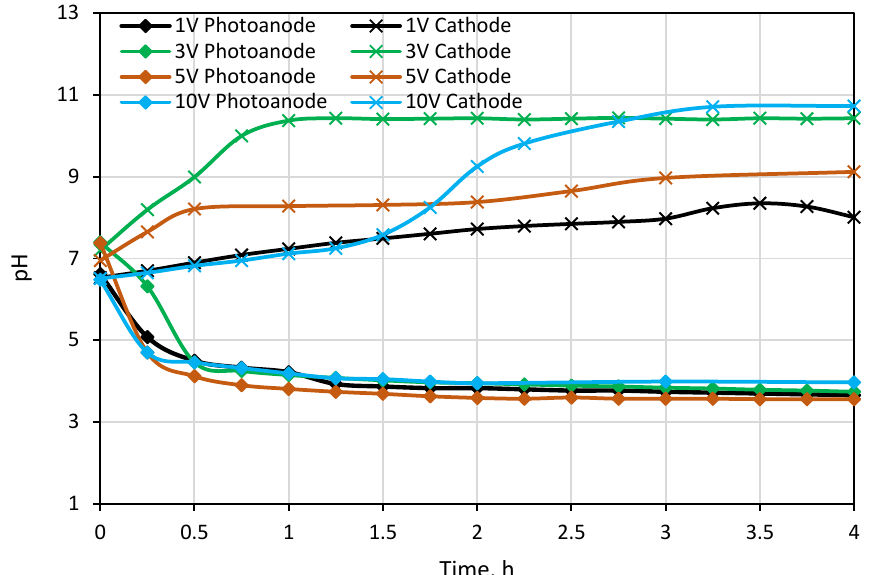
Figure 4. Change in pH values in Photoanode and cathode cell.